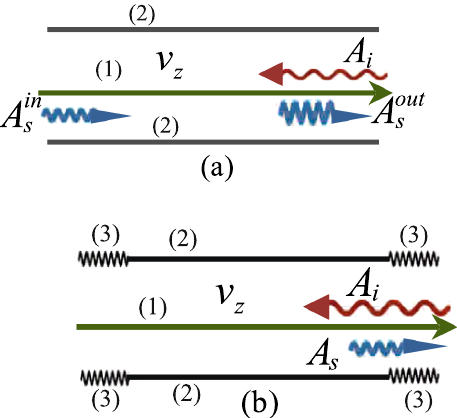
FIG. 1. Schematic of amplifier (a) and generator (b) with incoherent pump wave. (1) Electron beam; (2) waveguide; (3) Bragg